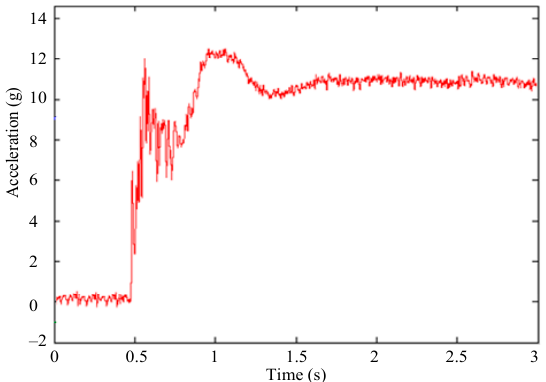
Figure 10. Impact acceleration test results for the arm.